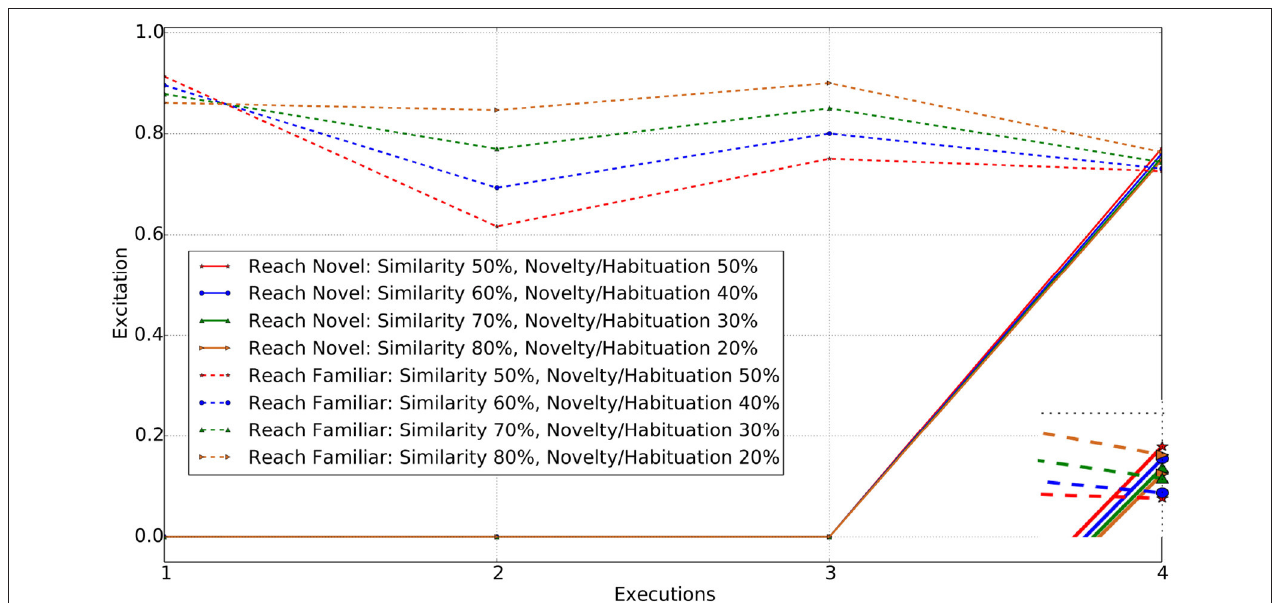
FIGURE 7 | Reach actions for Familiar vs. Novel object (changed in both color and shape). Enclosed Figure shows the excitations at the 4 th execution.